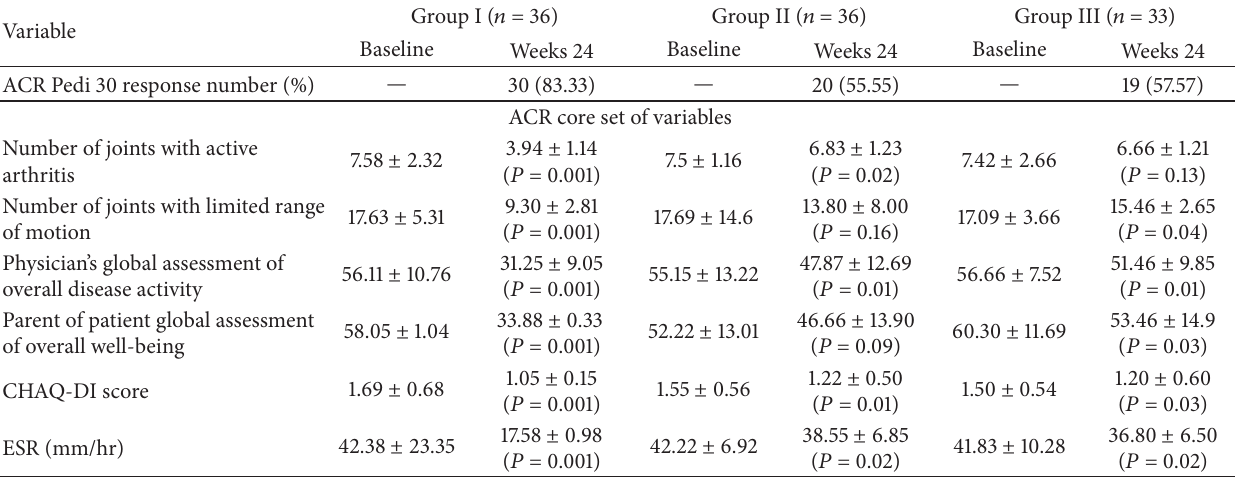
Table 2: Evolution from baseline of ACR core set data at the end of the sublingual laser blood